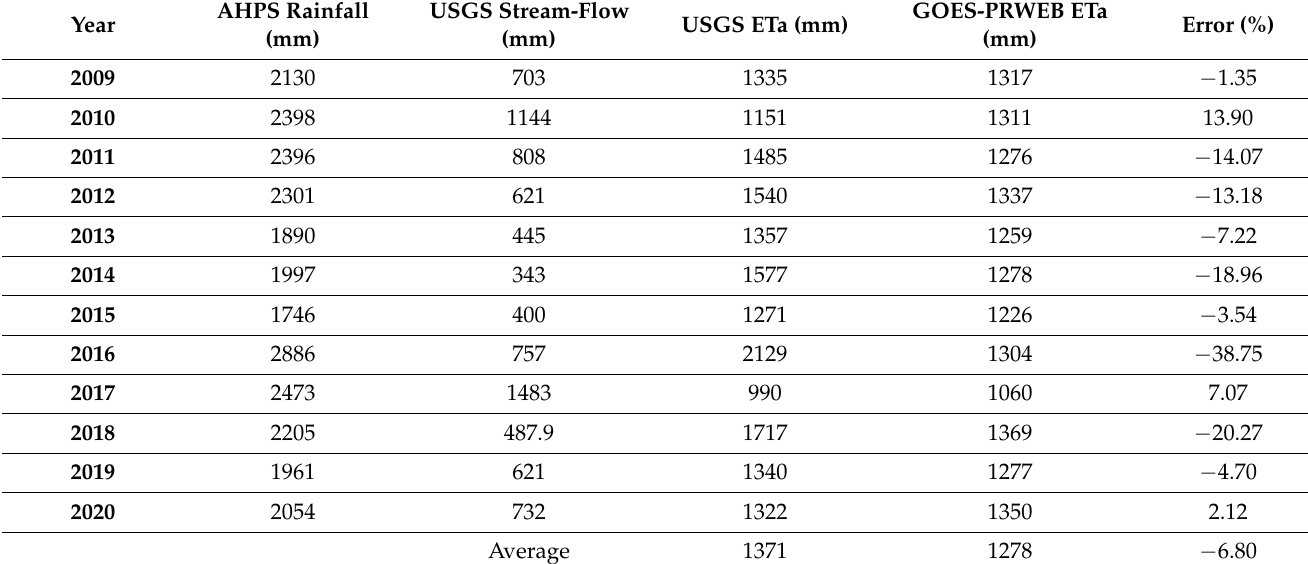
Table 2. Comparison of the Guanajibo watershed annual ET a derived from AHPS rainfall and USGS Streamflow data * with GOES-PRWEB ET a for 2009–2020.